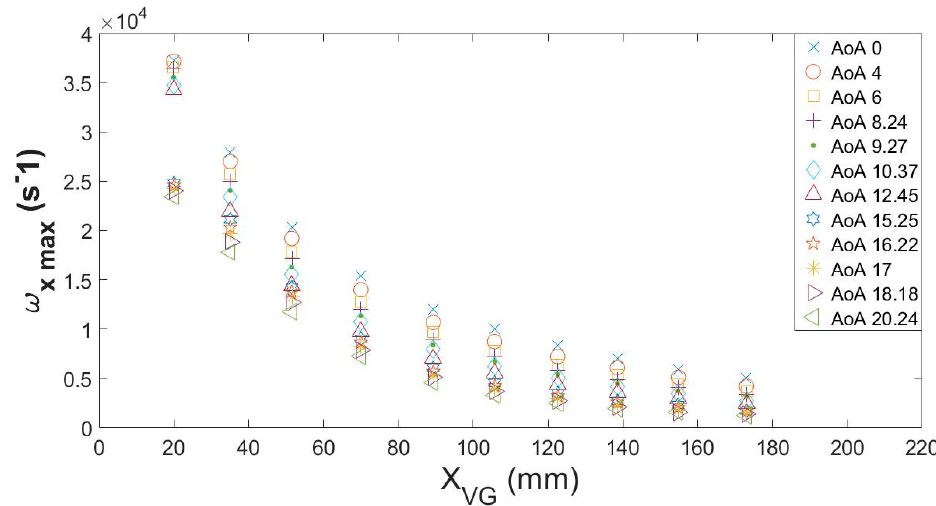
Figure 9. Comparison of vortex decay at different chord positions for all angles of attack (AoAs).